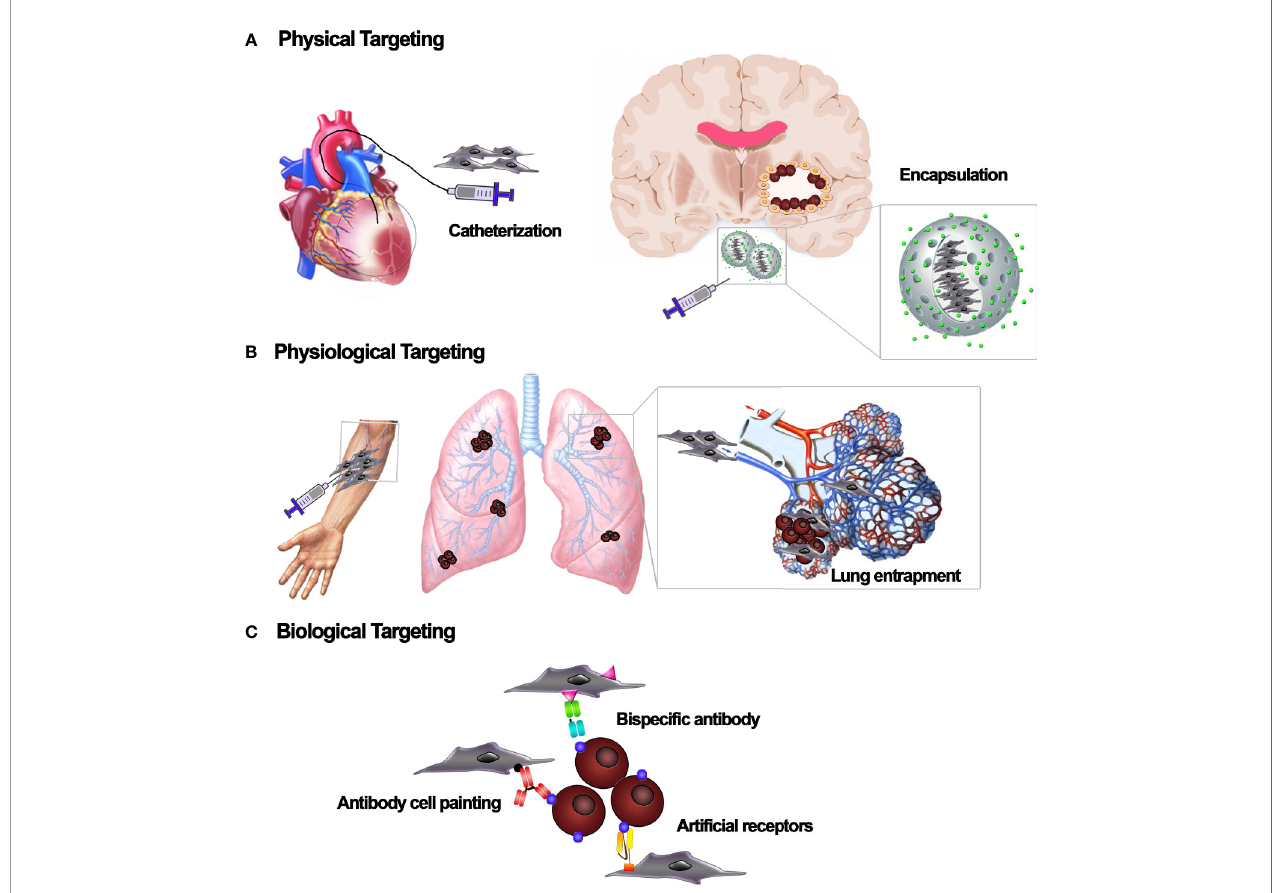
FIGURE 3 | Cell-based targeting strategies. Different targeting strategies to localize mesenchymal stromal/stem cell (MSC) carriers to the tissue of interest. (A) Physical targeting relies on the use of devices, such as catheters or scaffolds, to position the cells where they are needed. (B) Physiological targeting takes advantage of natural forces that route transplanted cells to speci fi c sites or organs. Based on the infusion site, cells can be physiologically entrapped by the vascular bed of speci fi c tissues. (C) Biological targeting strategies embody a range of molecular techniques to target cell vehicles. Adapters such as bispeci fi c antibodies, “ cell painting ” with antibodies or peptides, and expression of arti fi cial receptors enable the af fi nity-based retention of cell vehicles at the target